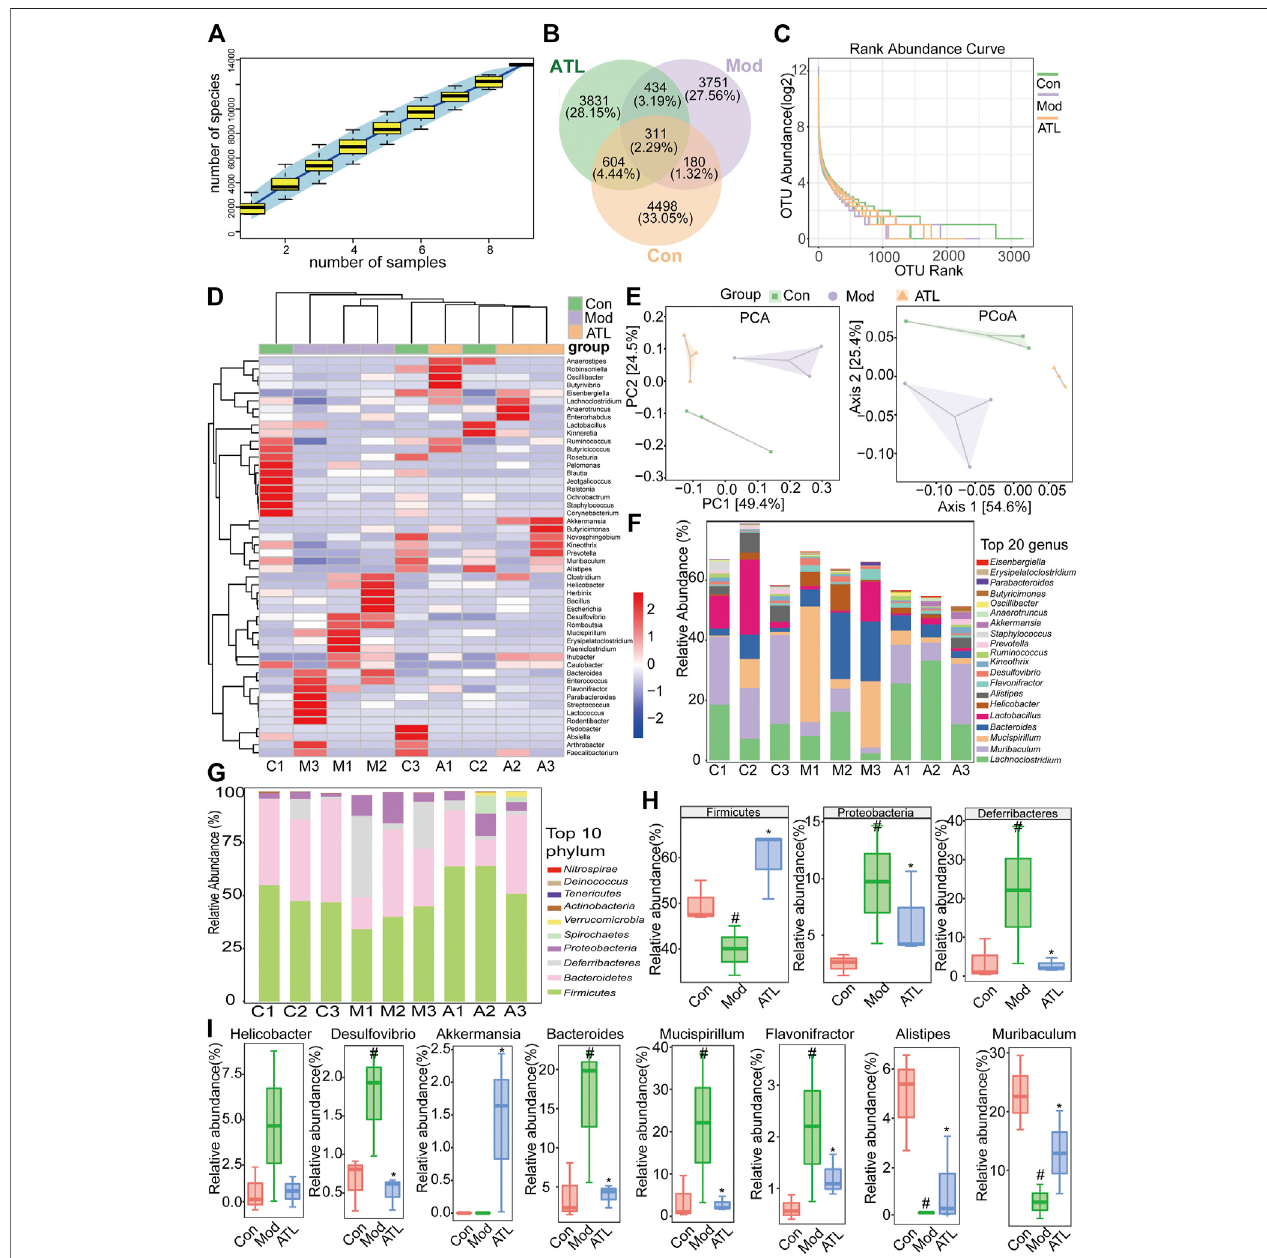
FIGURE 6 | ATL can improve the intestinal microbiota of DSS-induced colitis in mice (A) Sample number and species richness were estimated from a species accumulation boxplot (B) Venn diagram ofspecies (C) Abundance grade curve ofspecies level (D) Heatmap demonstratingthe relative abundance of intestinal bacteria at the genus level (E) PCA (principal component analysis) and PCoA (principal coordinates analysis) demonstrated distinct structural changes in the overall bacterial community for each group (F) Microbial community bar plot at the genus level (G) Microbial community bar plot at the phylum level (H) Relative abundance of different microbial fl ora at the phylum level and the genus level (I) Data were obtained from three independent experiments and are presented as the mean ± SEM. Data were analyzed using one-way ANOVA, n (cid:1) 3. # p < 0.05 compared to the control group. * p < 0.05 compared to the model group.